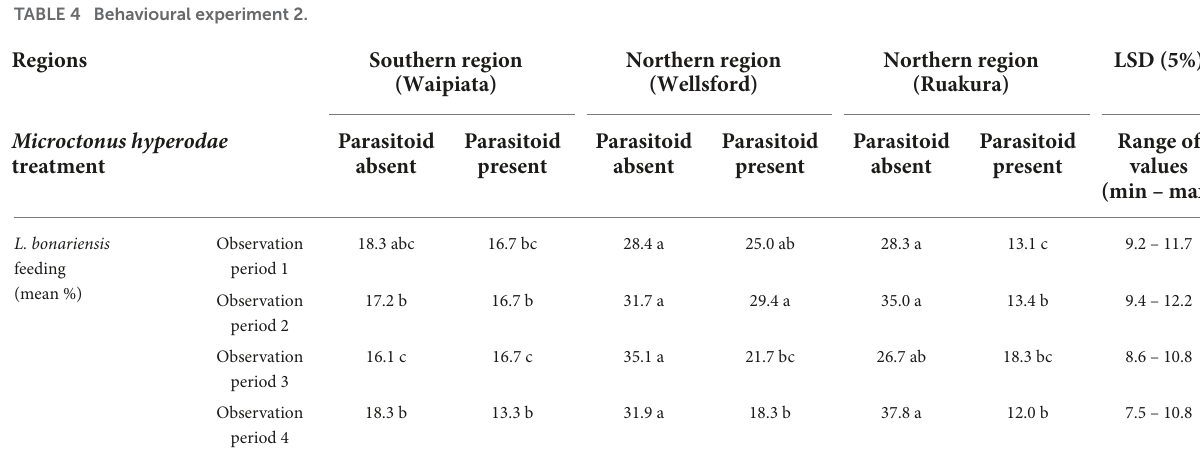
TABLE 4 Behavioural experiment